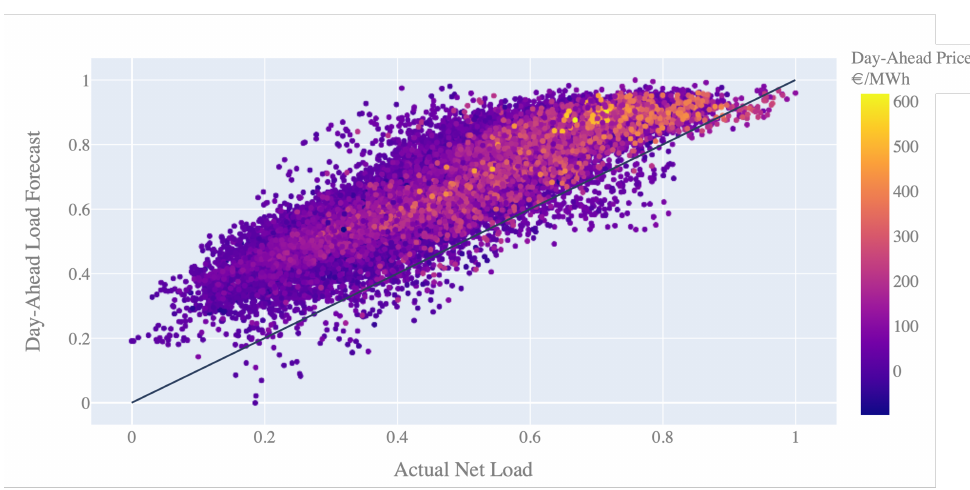
Figure 7. Cost for redispatch measures in the 50 HzT since 2017, varying over the time of the